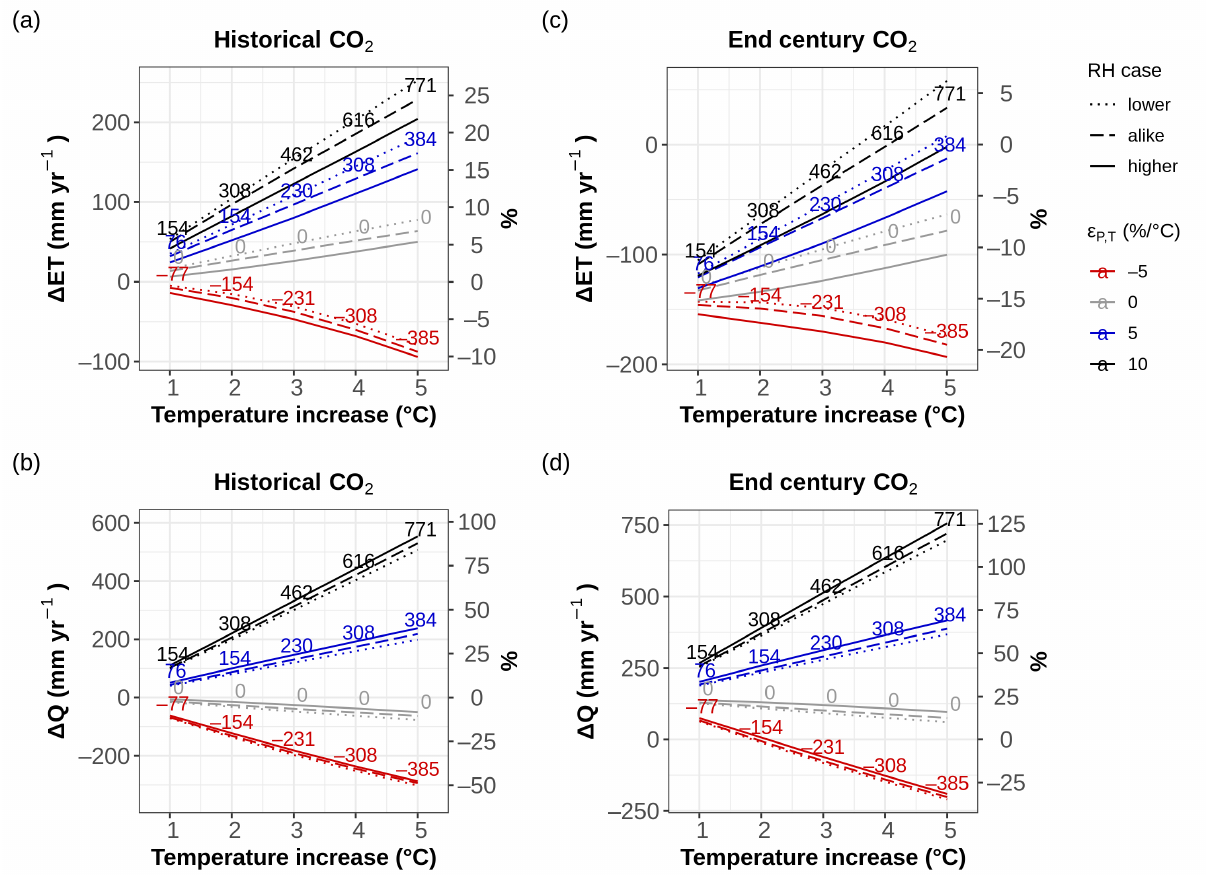
Figure 7. Hydrological responses of ET and Q shown as differences of experiment minus control simulation (ET, Panels ( a , c )) and specific discharge (Q, Panels ( b , d )), in mm yr − 1 (left y -axis) and percentage variation (right y -axis), forced by: temperature increase ( x -axis, in ◦ C); elasticity of precipitation to temperature (cid:101) P , T , in % ◦ C − 1 (colors), with actual changes of precipitation displayed as labels, in mm yr − 1 ; changes of relative humidity (RH) with the cases lower (dotted line), alike (dashed line), and higher (solid line); and changes of CO 2 concentration (historical in Panels ( a , b ) and end of the century in Panels ( c , d